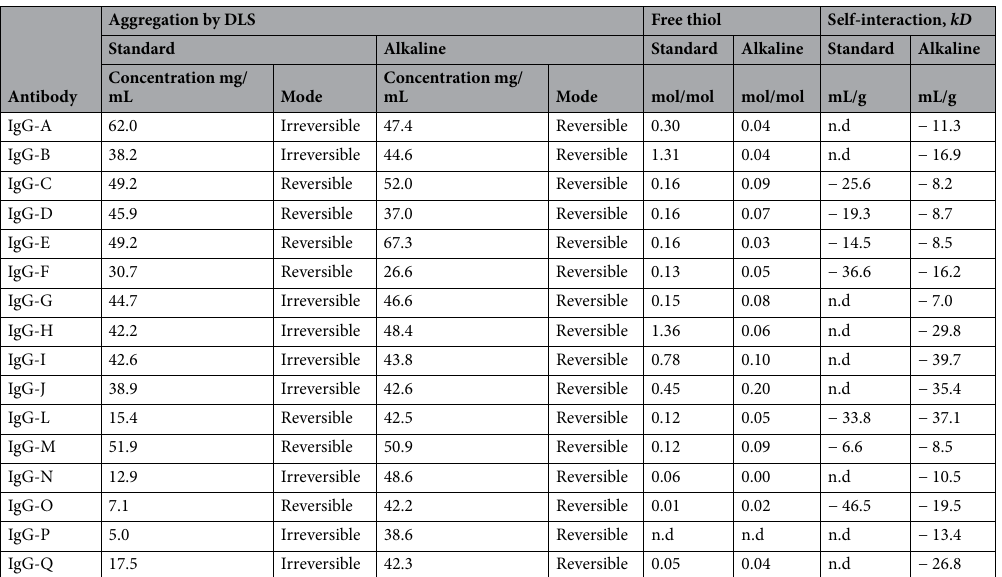
Table 2. Effects of alkaline wash on physicochemical characteristics. n.d., not